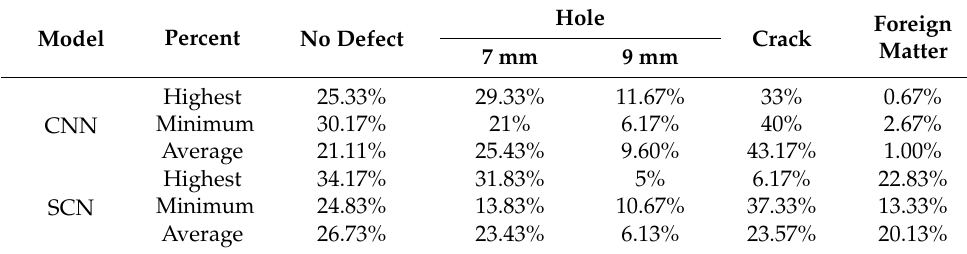
Table 8. Recognition results of the 5 mm hole defect